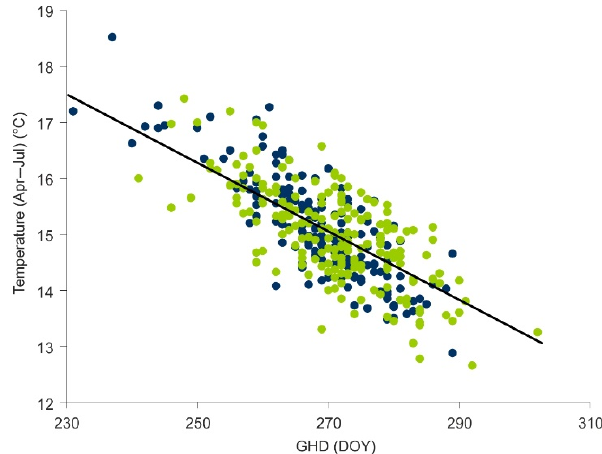
Figure 6. Relation between April-to-July mean temperature ( ◦ C) in Paris and Beaune GHDs. Green dots indicate the calibration period, and blue dots the evaluation period. The linear regression line is